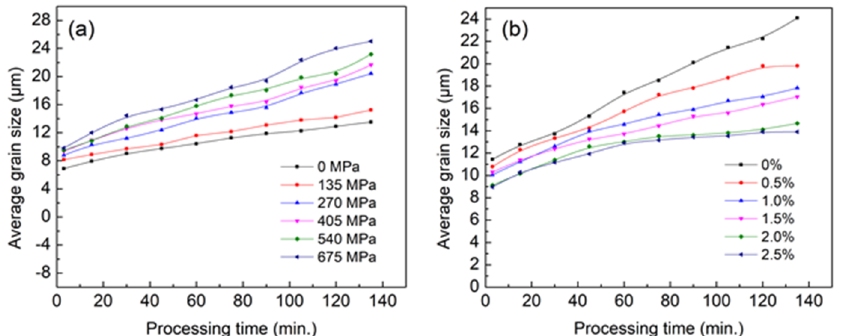
Figure 7. ( a ) Average grain size under different stress at 573 K; and ( b ) the average grain size evolution at 573 K with second phase particles of different